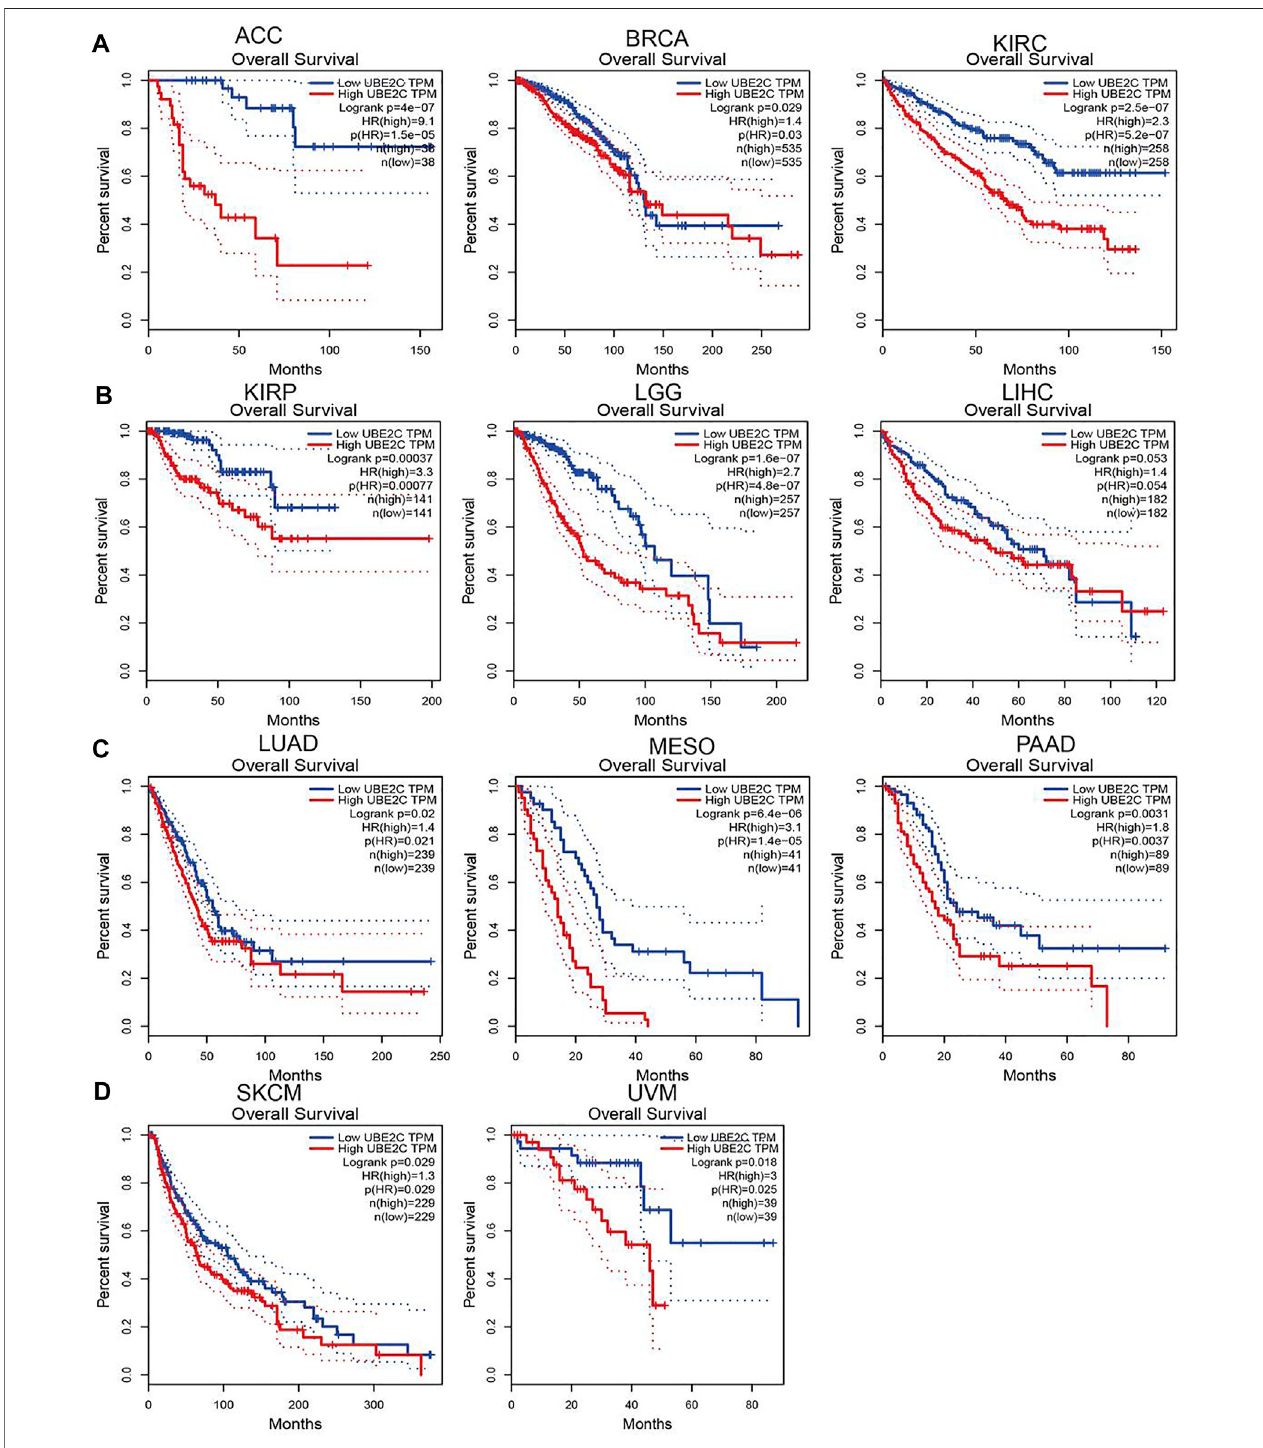
FIGURE3| Analysisofthe overallsurvival forUBE2Cinhuman cancers. (A) Theoverall survivalfor UBE2Cin ACC,BRCAand KIRC; (B) KIRP, LGG and LIHC; (C) LUAD, MESO, and PAAD; (D) and SKCM and UVM examined by the GEPIA database.